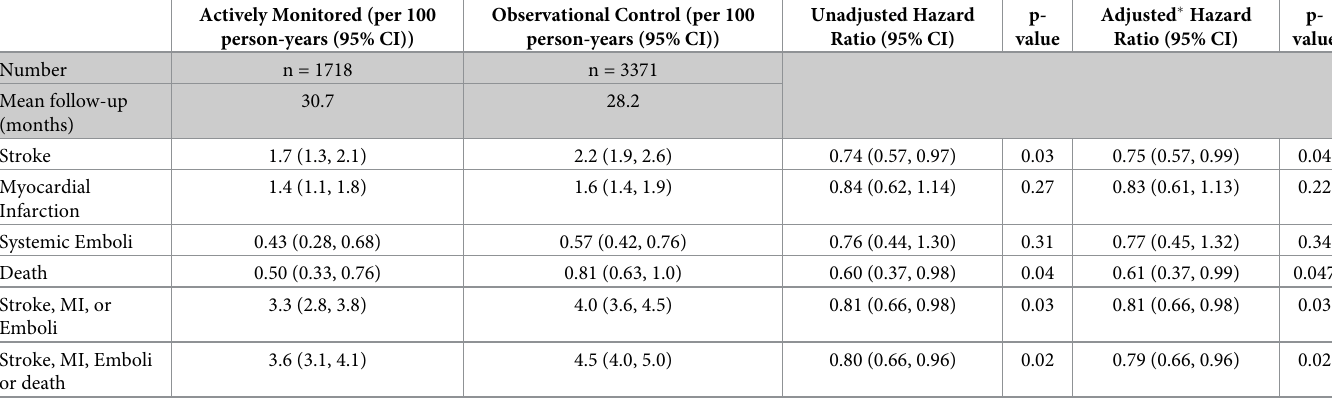
Table 2. Unadjusted and adjusted clinical outcomes at 3 Years.